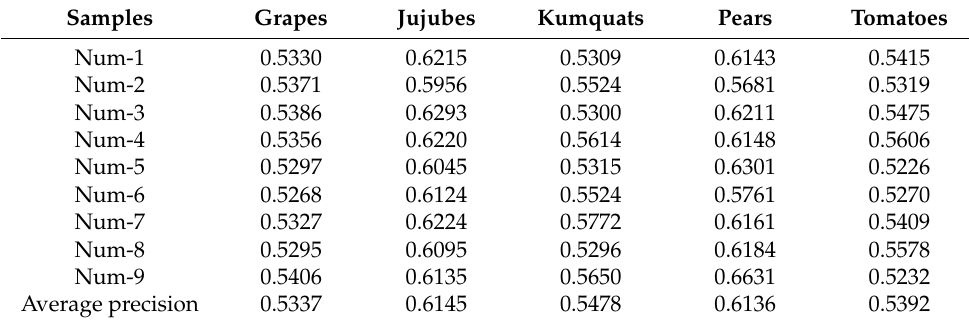
Table 8. Testing five samples using the support vector machine (SVM).